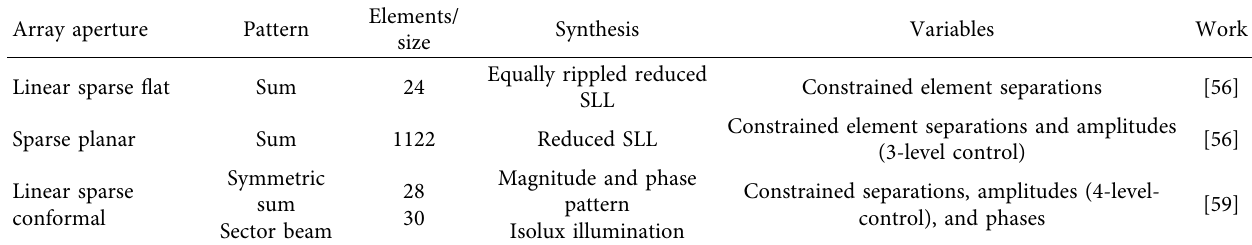
Table 5: AAP-based deterministic synthesis method: applications and features.